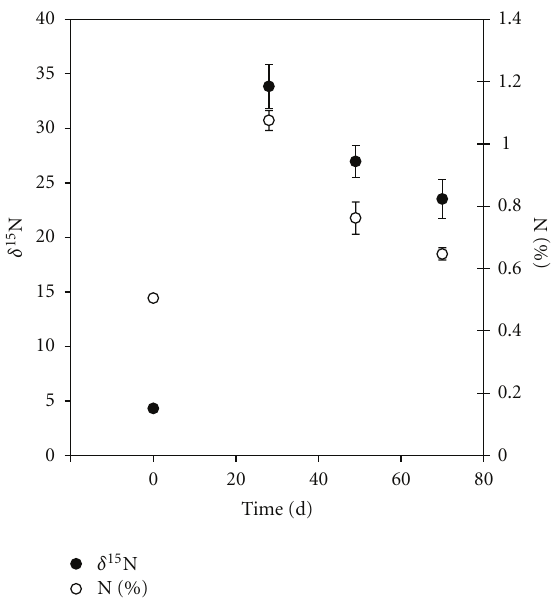
Figure 2: Observed change of δ 15 N and N concentration in grass shoots during the RA experiment. Vertical bars indicate the standard error of mean ( n =